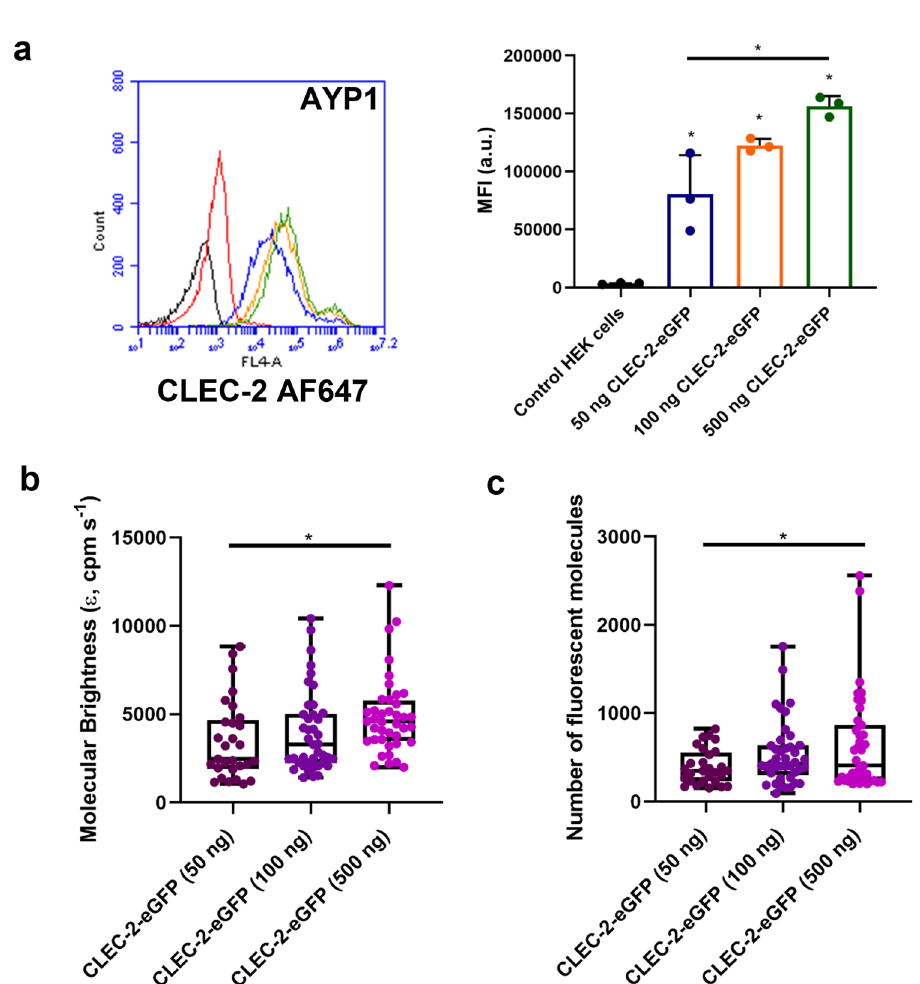
Fig. 9 CLEC-2 dimerisation increases with receptor expression. a Wild-type HEK293T cells were transfected with 50, 100 or 500 ng of CLEC-2-eGFP DNA by PEI. CLEC-2-eGFP expression in HEK293T cells was measured by fl ow cytometry using mAb AYP1 (10 µ g/ml) with Alexa Fluor-647 anti-mouse secondary antibody. Representative fl uorescence intensity histograms for 50 (Blue), 100 (Orange) and 500 (Green) ng CLEC-2-eGFP transfected HEK293T samples. The black histogram shows HEK293T cells with no stain and the red histogram shows non-speci fi c secondary staining alone. Flow cytometry data presented as MFI (a.u.). Data presented as mean ± SD ( n = 3 biologically independent experiments). Box plots showing the effect of increasing receptor expression on CLEC-2-eGFP ( b ) molecular brightness ( ε , counts per molecule per second, cpm s − 1 ) and ( c ) number of fl uorescent molecules within the confocal volume measured by FCS. For all box plots, centre lines represent the median; box limits indicate the 25th and 75th percentiles and whiskers extend to minimum and maximum points. Signi fi cance was measured with a one-way ANOVA with Bonferroni post-hoc for ( a ) and a Kruskal-Wallis with Dunn ’ s post-hoc for ( b – c ) where P ≤ 0.05. FCS measurements were taken in 45 – 67 cells ( n = 3 biologically independent